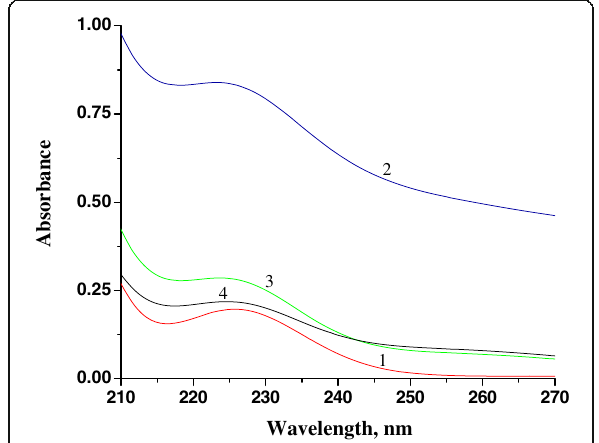
Fig. 3 UV-Vis spectra of CTMA solutions in the ratio 1:1 and 1:2 with LS, and the addition of CaCO 3 . 1 — CTMA . 2 — CTMA + LS (1:1). 3 — CTMA 4 — CTMA + LS (1:2)+CaCO + LS (1:1)+CaCO 3 .